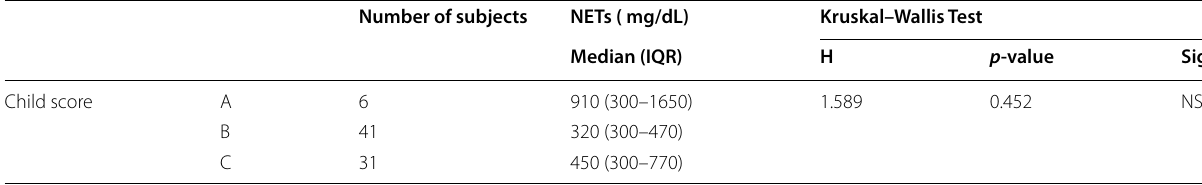
Table 4 Relation between NET levels and Child score